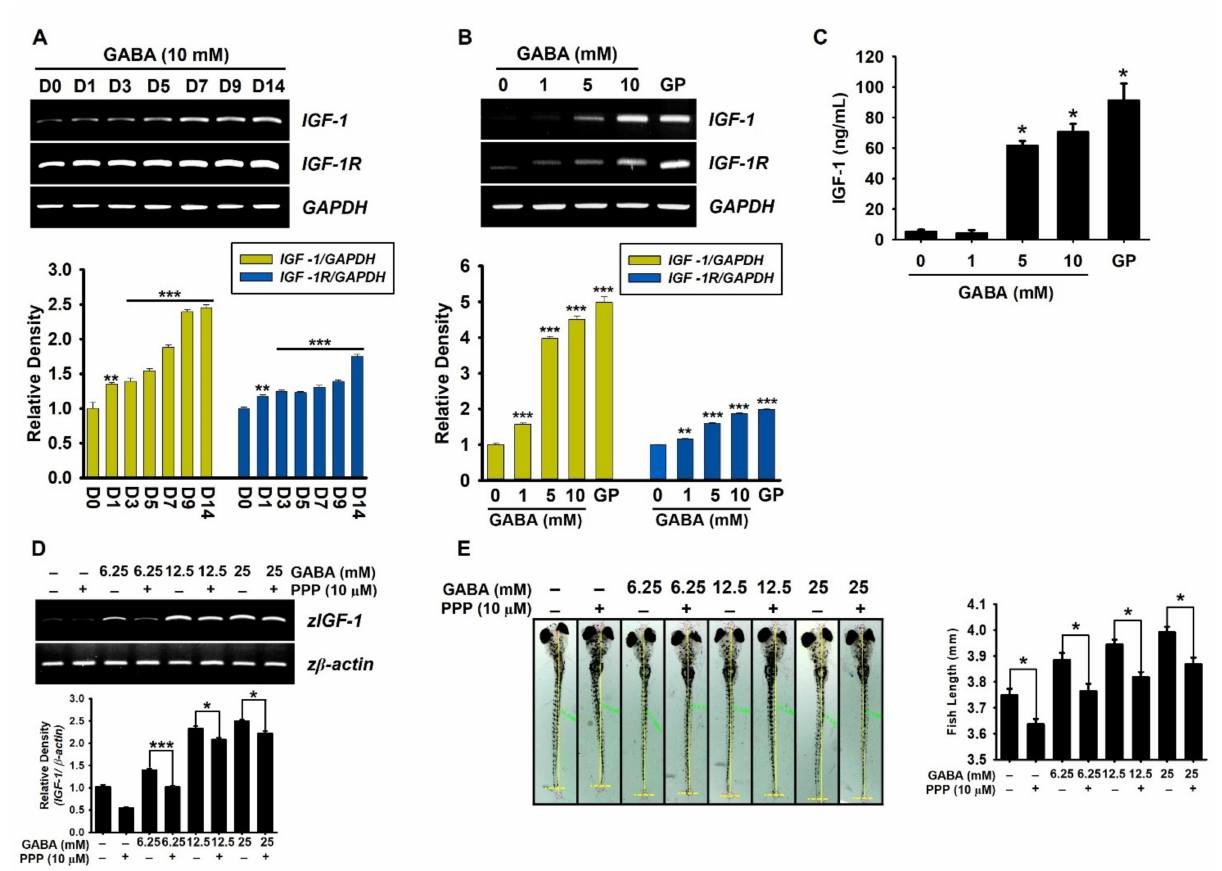
Figure 2. GABA enhances IGF-1 release, leading to an increase in growth rate via IGF-1R. ( A ) Preosteoblast MC3T3-E1 cells (1 × 10 4 cells/mL) were treated with 10 mM GABA for 14 days ( D ), and the media were replaced every three days with GABA. ( B ) In a parallel experiment, MC3T3-E1 cells were treated with GABA (0–10 mM) and 2 mM β -glycerophosphate (GP) for seven days. Total RNA was extracted at the indicated time points, and cDNA was synthesized. RT-PCR was performed to determine the expression level of IGF-1 and IGF-1R . Glyceraldehyde 3-phosphate dehydrogenase gene ( GAPDH ) was used as an internal control. The expression of IGF-1 and IGF-1R relative to that of GAPDH level was determined ( bottom ). ( C ) To evaluate extracellular IGF-1 release, MC3T3-E1 cells (1 × 10 4 cells/mL) were treated with GABA (0–10 mM) and 2 mM GP for seven days. Cell culture media were collected, and colorimetric enzyme-linked immunosorbent assay (ELISA) was performed. ( D , E ) Zebrafish larvae ( n = 20) at three days post-fertilization (dpf) were pretreated with 10 µ M picropodophyllin (PPP) 2 h before treatment with GABA (0–25 mM). ( D ) RT-PCR was performed to determine the expression of IGF-1. The expression of IGF-1 relative to that of z β -actin level was determined ( bottom ). ( E ) Total body length was measured at 9 dpf using a stereomicroscope ( × 4). Graph represents the total body length of zebrafish larvae ( right ). Significant differences among the groups were determined using Student’s t -test and one-way ANOVA followed by Bonferroni correction. All data are presented as mean ± standard error of the mean (* p < 0.05, ** p < 0.01, and *** p <